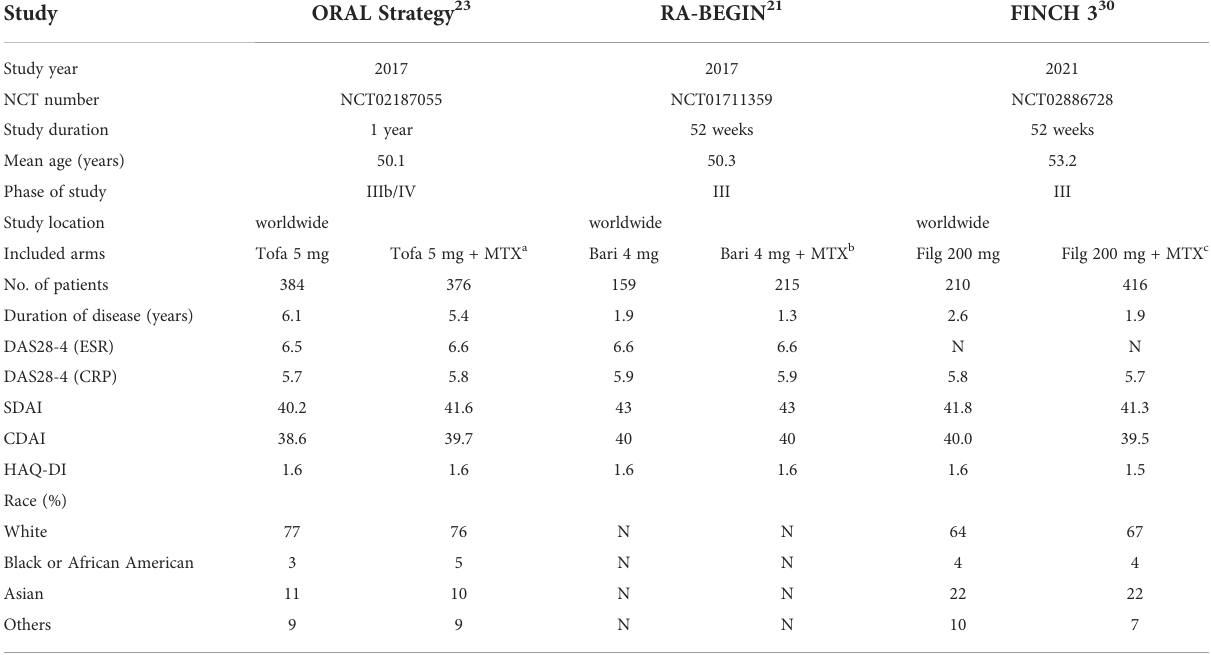
TABLE 1 Characteristics of included randomized controlled trials.